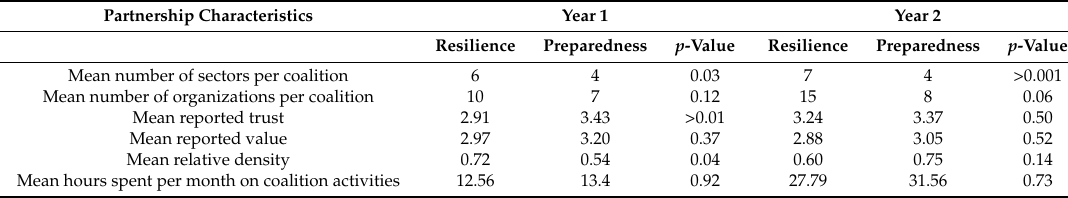
Table 1. Differences in Partnership Characteristics by Community Type and